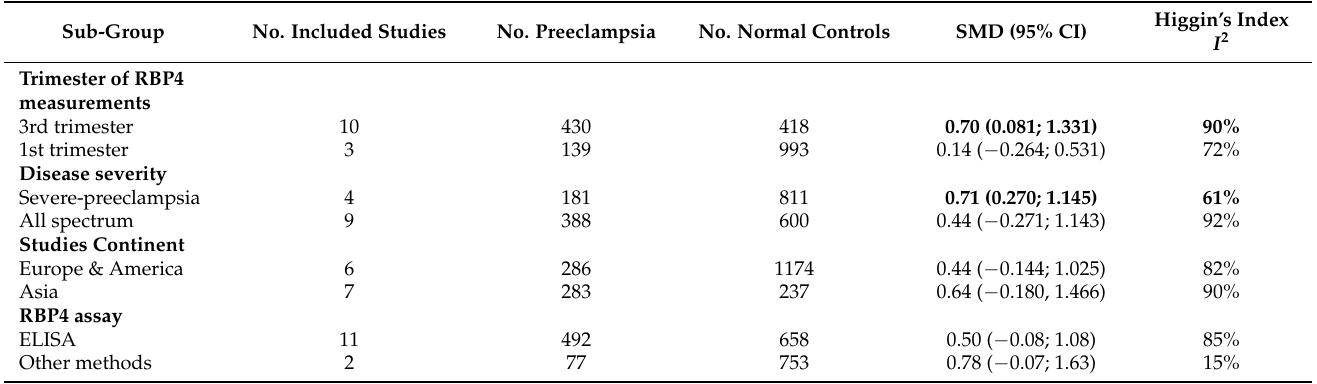
Table 2. Subgroup analysis of the association between retinol-binding protein 4 and